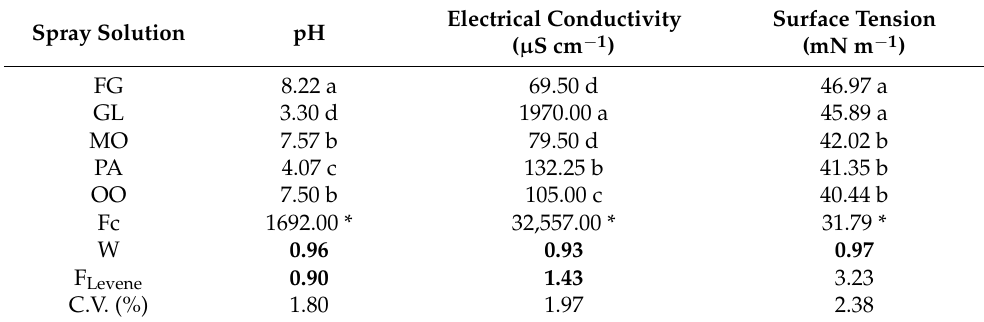
Table 2. Hydrogen-ion potential (pH), electrical conductivity ( µ S cm − 1 ), and surface tension (mN m − 1 ) of different fungicide solutions in mixture with glyphosate or adjuvants. Spray Solution